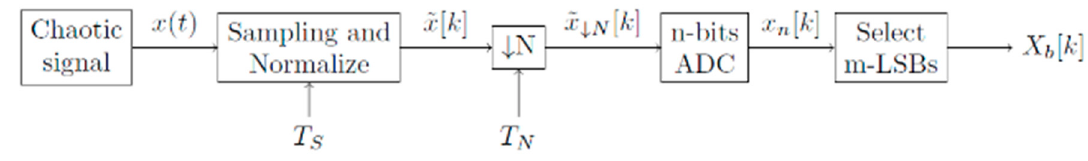
Figure 5. Block diagram of the random number generator modified with reduction of sample rate and normalization of the input signal.